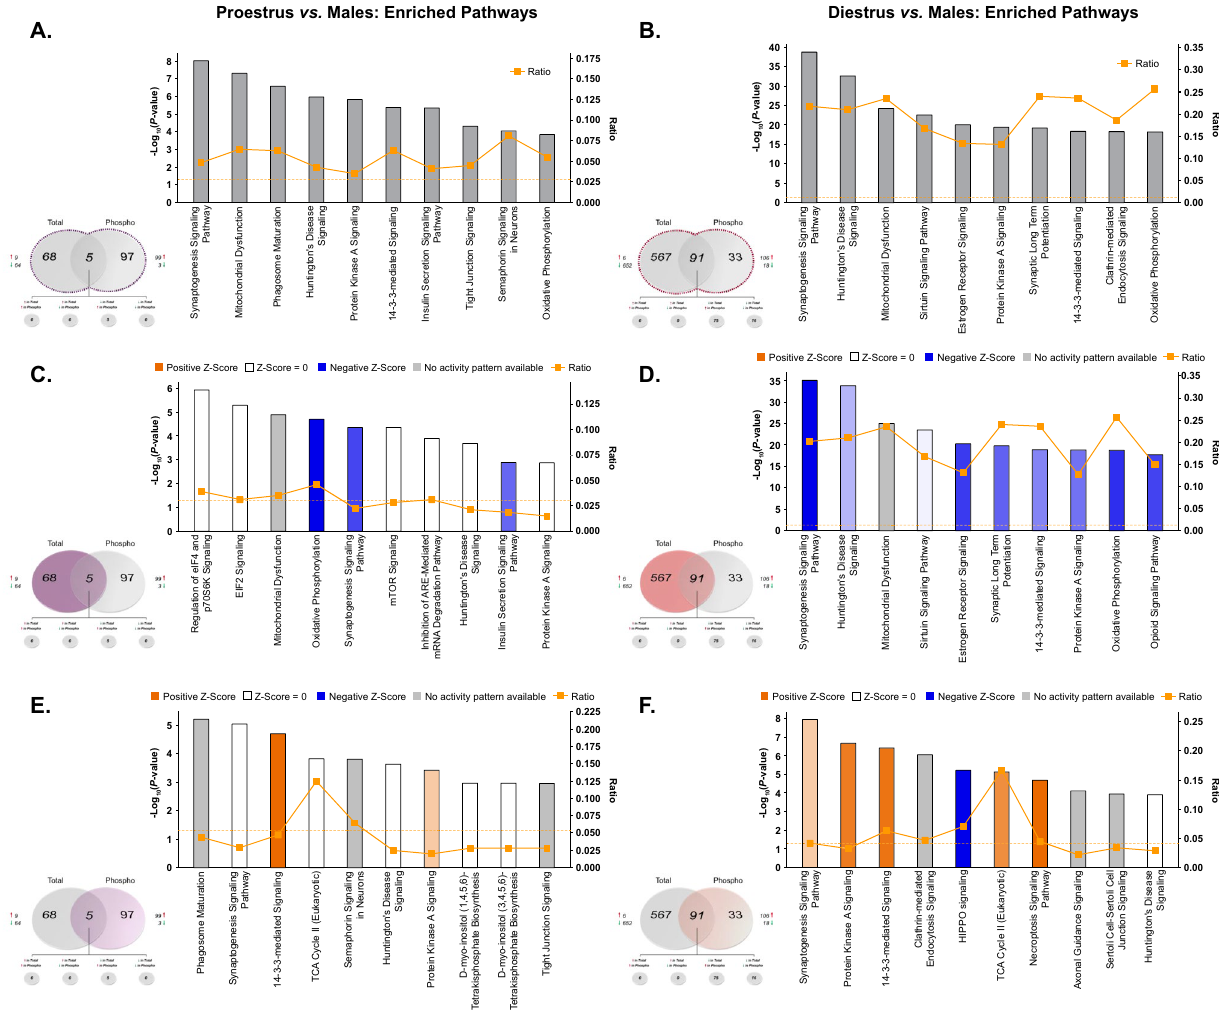
Figure 7. IPA enrichment analyses of estrous cycle-specific differences in protein and phosphoprotein abundance between female and male rats. ( A , B ) Canonical pathway enrichment for combined list of proteins and phosphoproteins identified as differentially abundant ( p < 0.05) from proestrus vs. males ( A ) and diestrus vs. males comparisons. Separate IPA analyses of total proteins ( C , D ) and phosphoproteins ( E , F ) with estrous cycle- specific sex differences in abundance describe contributions of each fraction to predicted activity levels within enriched pathways. Based upon the direction of fold change of significant differentially abundant proteins/ phosphoproteins within the dataset, the Z -Score serves as a predictor of pathway activation states by assessing the match between the observed and predicted (evidence-based) up/down regulation patterns 41 . Pathways are colored by predicted activation state: orange (activated) or blue (inhibited), where darker colors represent higher absolute Z -scores. Z-scores for pathways colored in gray could not be calculated due to insufficient evidence for a prediction of either activation or inhibition to be made. The ratio (solid orange line) represents the number of molecules within the comparison dataset meeting the cutoff criterion ( p < 0.05; Fisher’s Exact Test), divided by the number of molecules comprising a given pathway within the reference set (Ingenuity Knowledge Base). Bar graphs were produced in Ingenuity Pathway Analysis (IPA) software (QIAGEN,